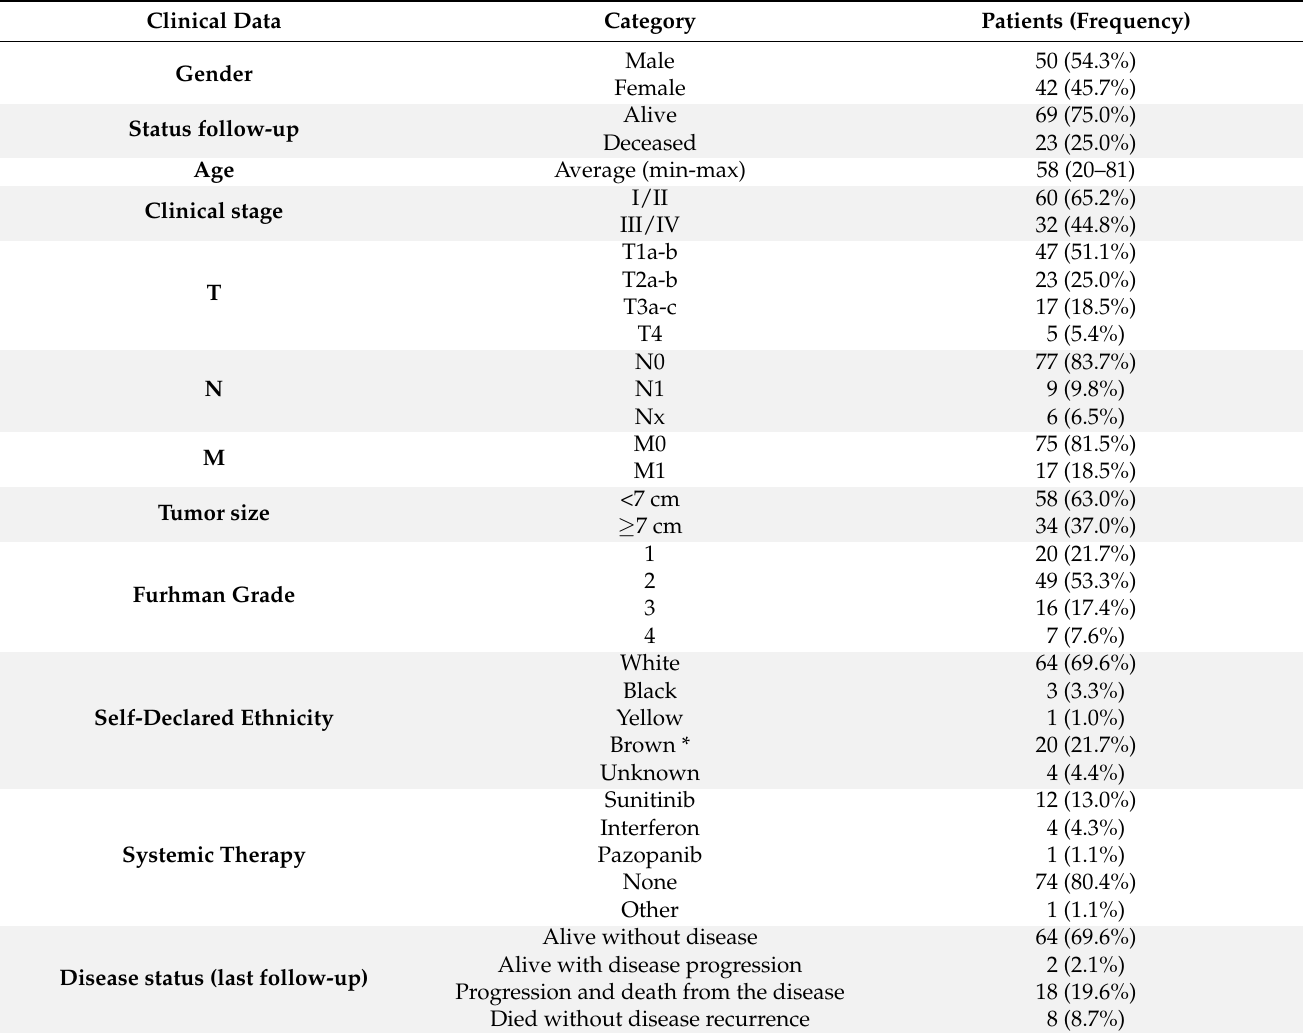
Table 1. Patient clinicopathological